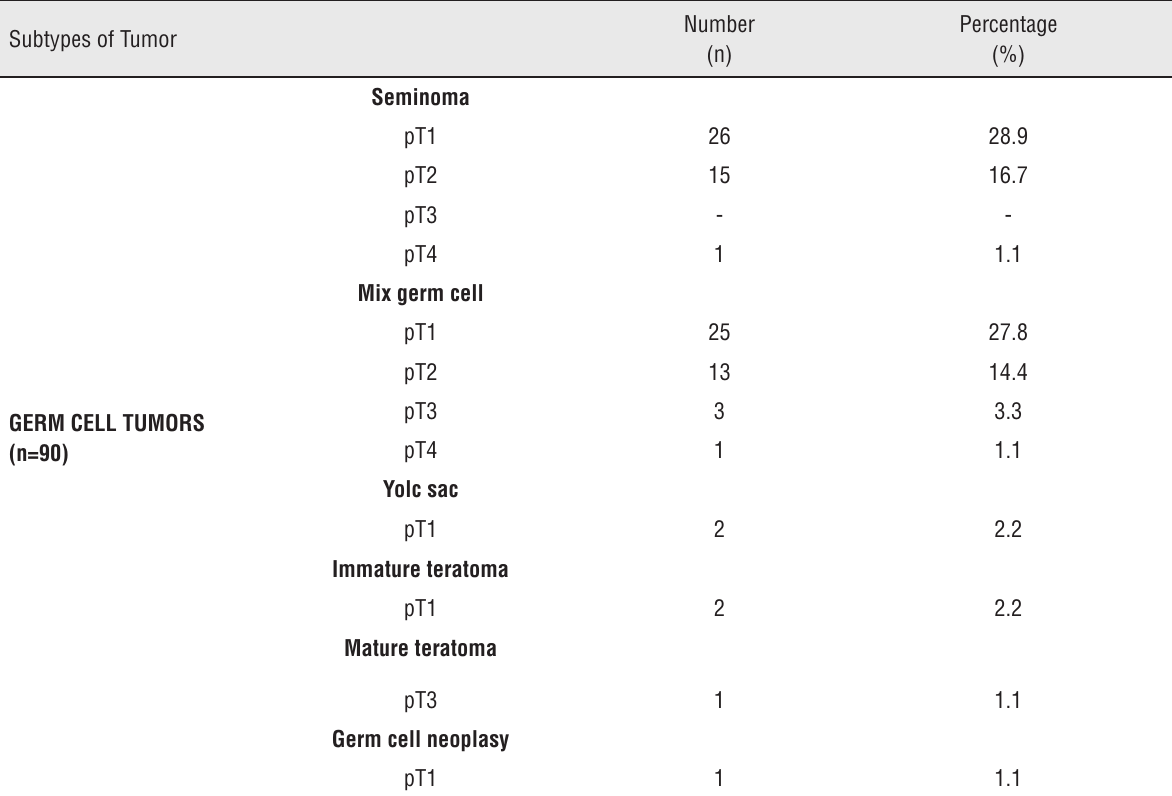
Table 2 - Tumor Classification and Pathological Stage